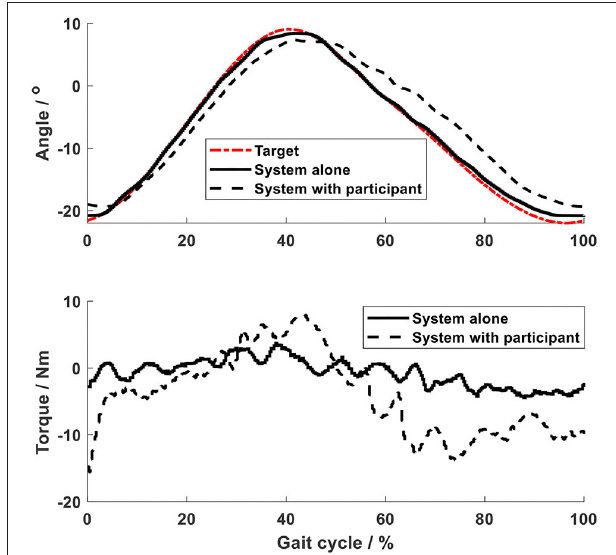
FIGURE 6 | Shoulder joint.